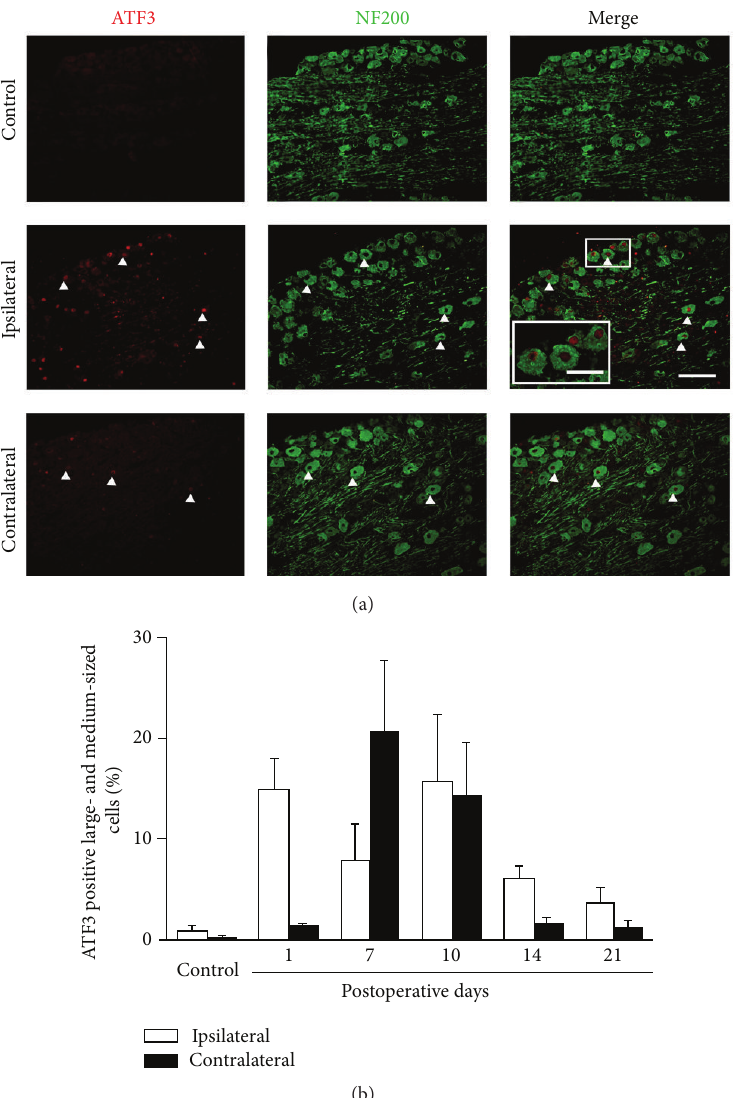
Figure 6: Increased ATF3 expressions in ipsilateral and contralateral large- and medium-sized DRG neurons following the mCCD. (a) ATF3 expression in ipsilateral large- and medium-sized DRG neurons of control rats. (b) ATF3 expression in ipsilateral large- and medium-sized DRG neurons at day 10 after mCCD surgery. C, ATF3 expression in contralateral large- and medium-sized DRG neurons at day 10 after mCCD surgery (inset: higher magnification, scale bar = 20 𝜇 m). D, Percentage of ATF3 positive cells in ipsilateral and contralateral large- and medium-sized DRG neurons in control and on the 1st, 7th, 10th, 14th, and 21st postoperative days. Scale bar = 50 𝜇 m (a–C). Bonferroni test, 𝑃 s < 0.001 , compared to the bilateral DRG neurons of control